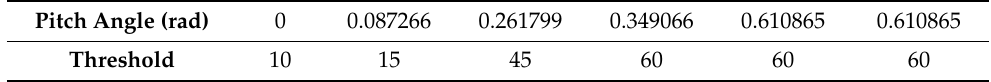
Table 2. Look-up table of the threshold value.